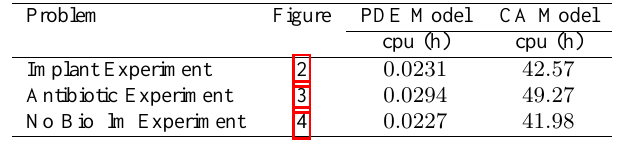
C OMPARATIVE COST OF THE CONTINUOUS AND